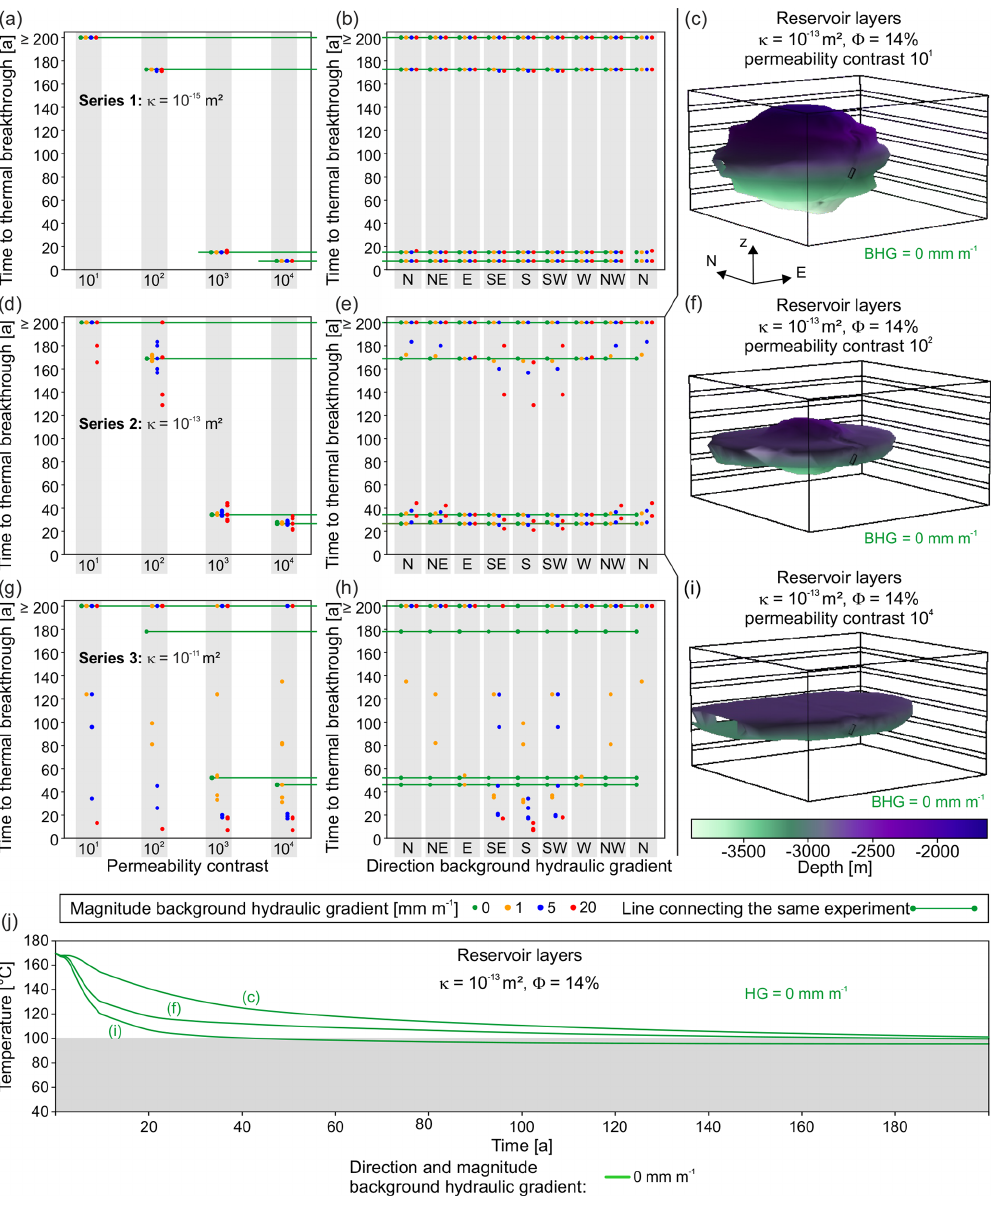
Figure 4. Parameter values against thermal breakthrough for model experiments with layered permeability contrasts (Scenario 2). Panels (a) to (b) , (d) to (e) , and (g) to (h) show the results of three permeability series. Each series contains the results of the same 100 simulations but are arranged according different x axes. The results show that a threshold exists for permeability contrasts between 2 and 3 orders of magnitude between reservoir and confining layers above which fluid exchange is suppressed. The result is an increasingly flatter shape of the HDI, i.e. a reduction of utilizable reservoir volume, which only at high permeabilities can be compensated for by a favourably oriented BHG. In (c) , (f) , and (i) , the shape of the HDI after 100 years is shown for the case of intermediate-permeability reservoir layers (series 2), permeability contrasts of 2, 3, and 4 orders of magnitude, and without applied BHG. Panel (j) shows the development of the production temperature over time for the models presented in (c) , (f) , and (i)